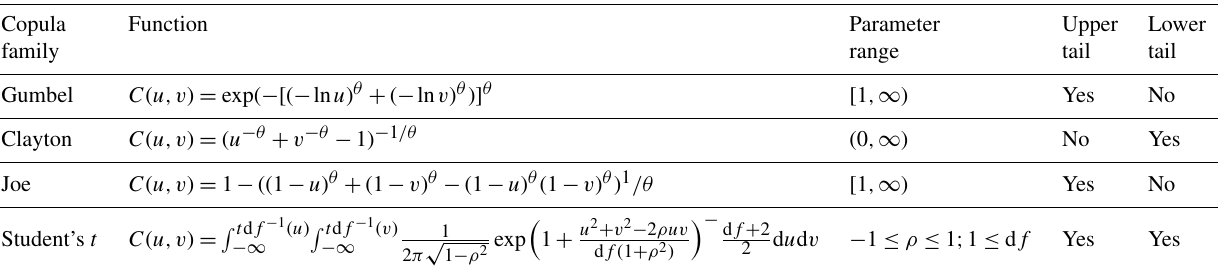
Table 1. Equations of the copula functions, where u and v are univariate variables (uniformly distributed), θ and ρ are the dependence parameters and df is the degree of freedom. Copula Function Parameter Upper Lower family range tail